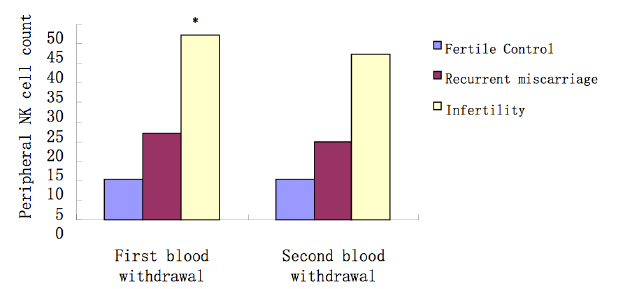
Figure 2: Percentage of NK cells (mean±SD) in the first and second blood withdrawal in recurrent miscarriage, infertile and fertile control group. (*) denotes significant differences (p=<0.05): First blood withdrawal vs. Second